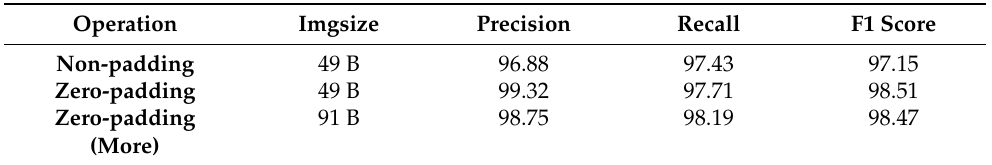
Table 5. The Shadowsocks traffic detection performance of the method using zero-padding and non-padding, respectively